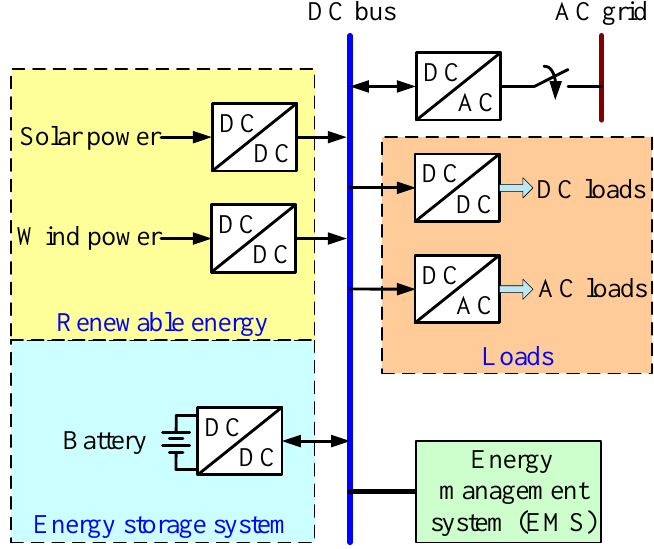
Figure 1. System configuration of the DC micro-grid.